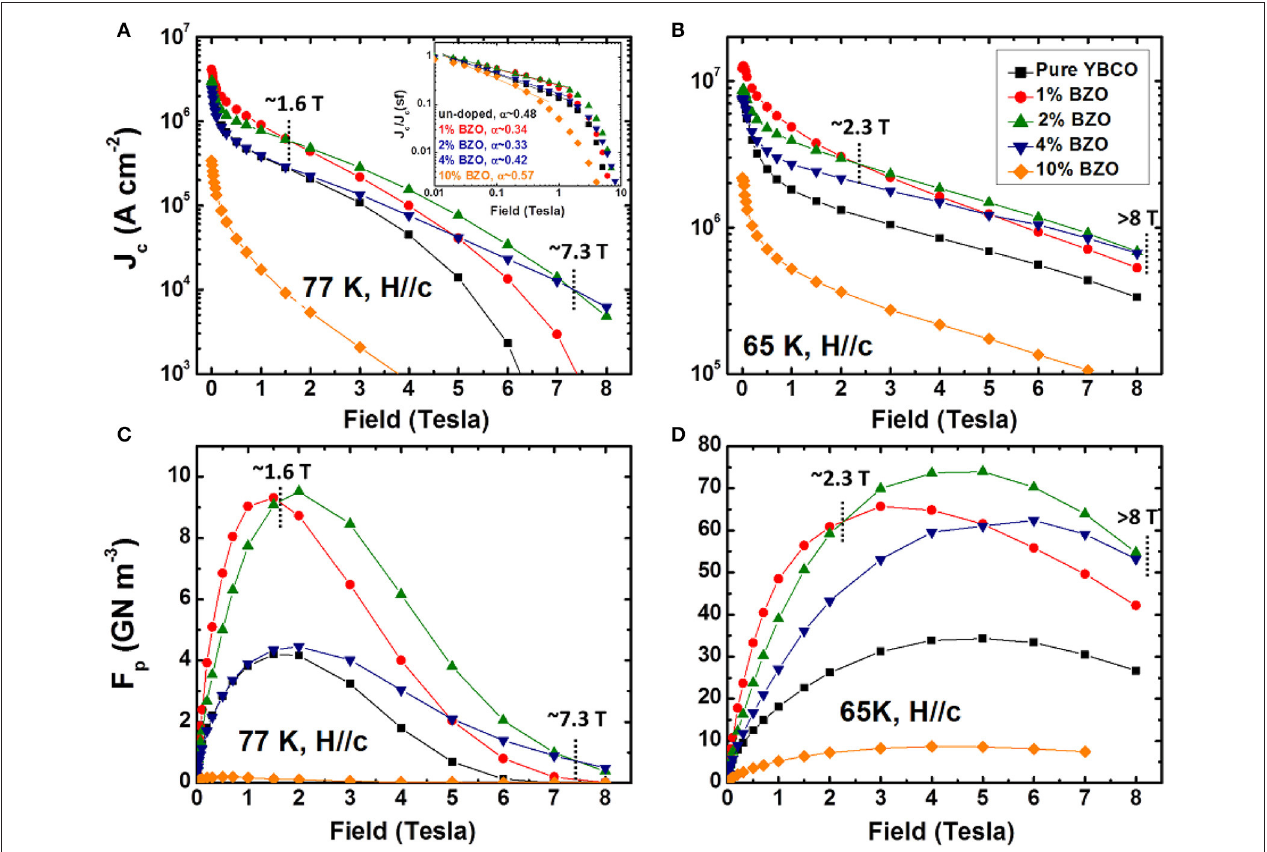
FIGURE 7 | Variation of J c and F p for pristine YBCO and YBCO:BZO thin films with varying concentration of BZO (1–10 vol%) at 77K (A,C) and 65K (B,D) . The inset of (A) shows normalized J c , J c ( H )/ J c (sf), for all the studied thin film samples. Reproduced from Wee et al. [85].